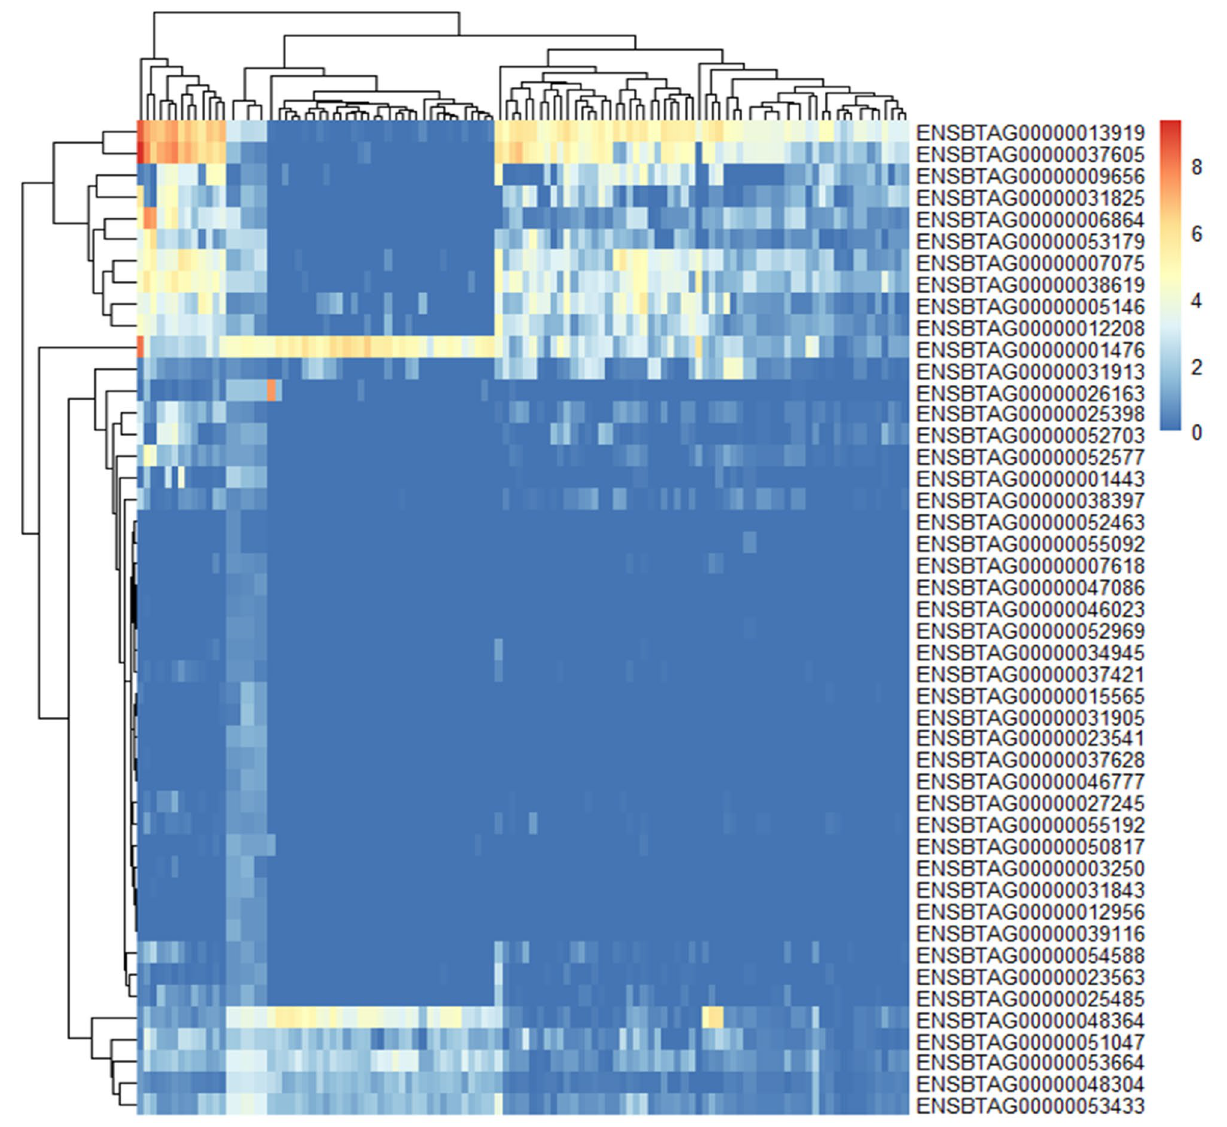
Figure 4. Expression pattern of 46 gene in chromosome 23: 24.8 M ~ 29.6